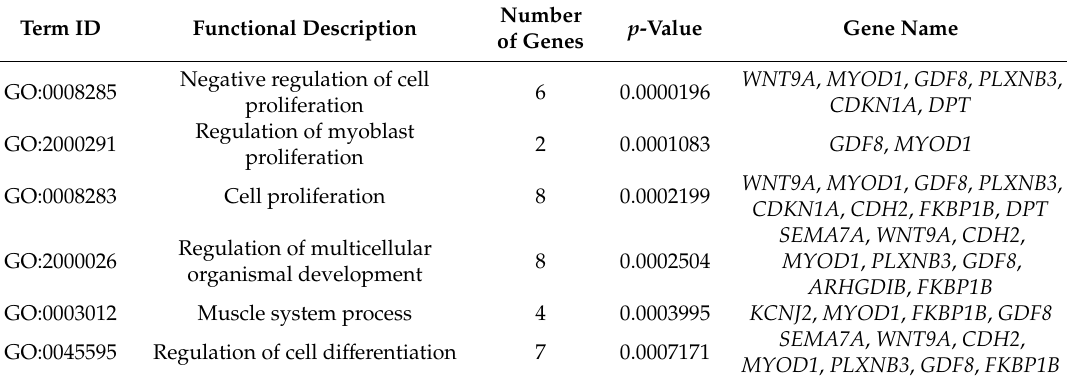
Table 8. The significantly enriched biological process terms for the eight-week-old males.